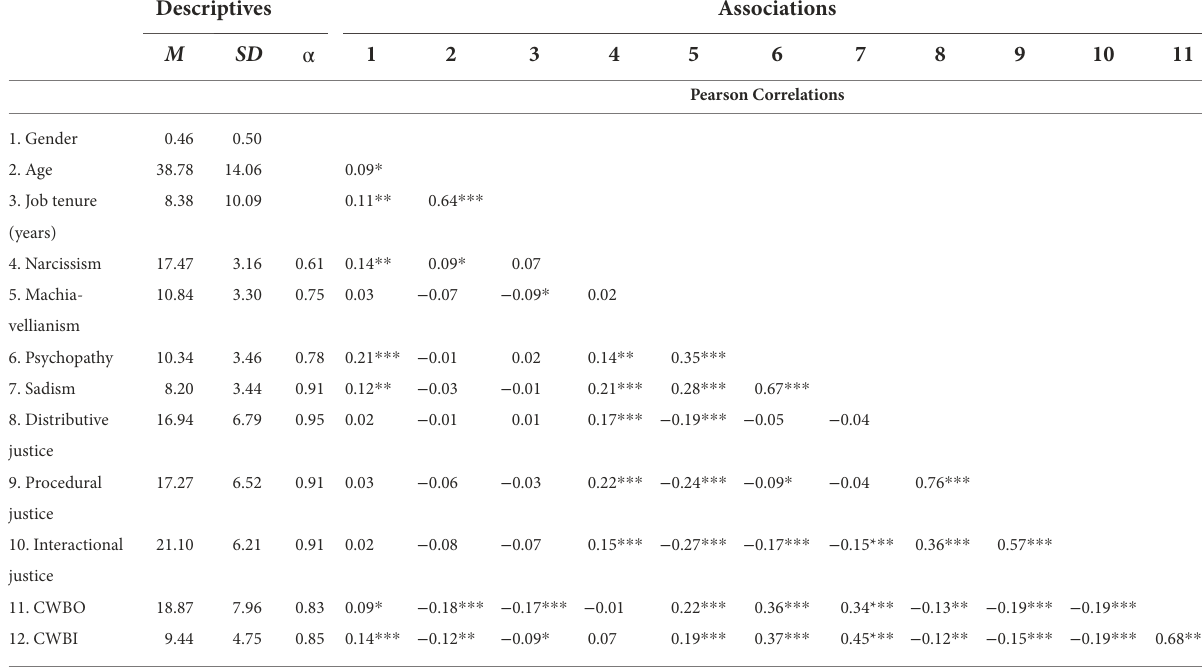
TABLE 1 Descriptive statistics, reliabilities, and bivariate relations of the variables.